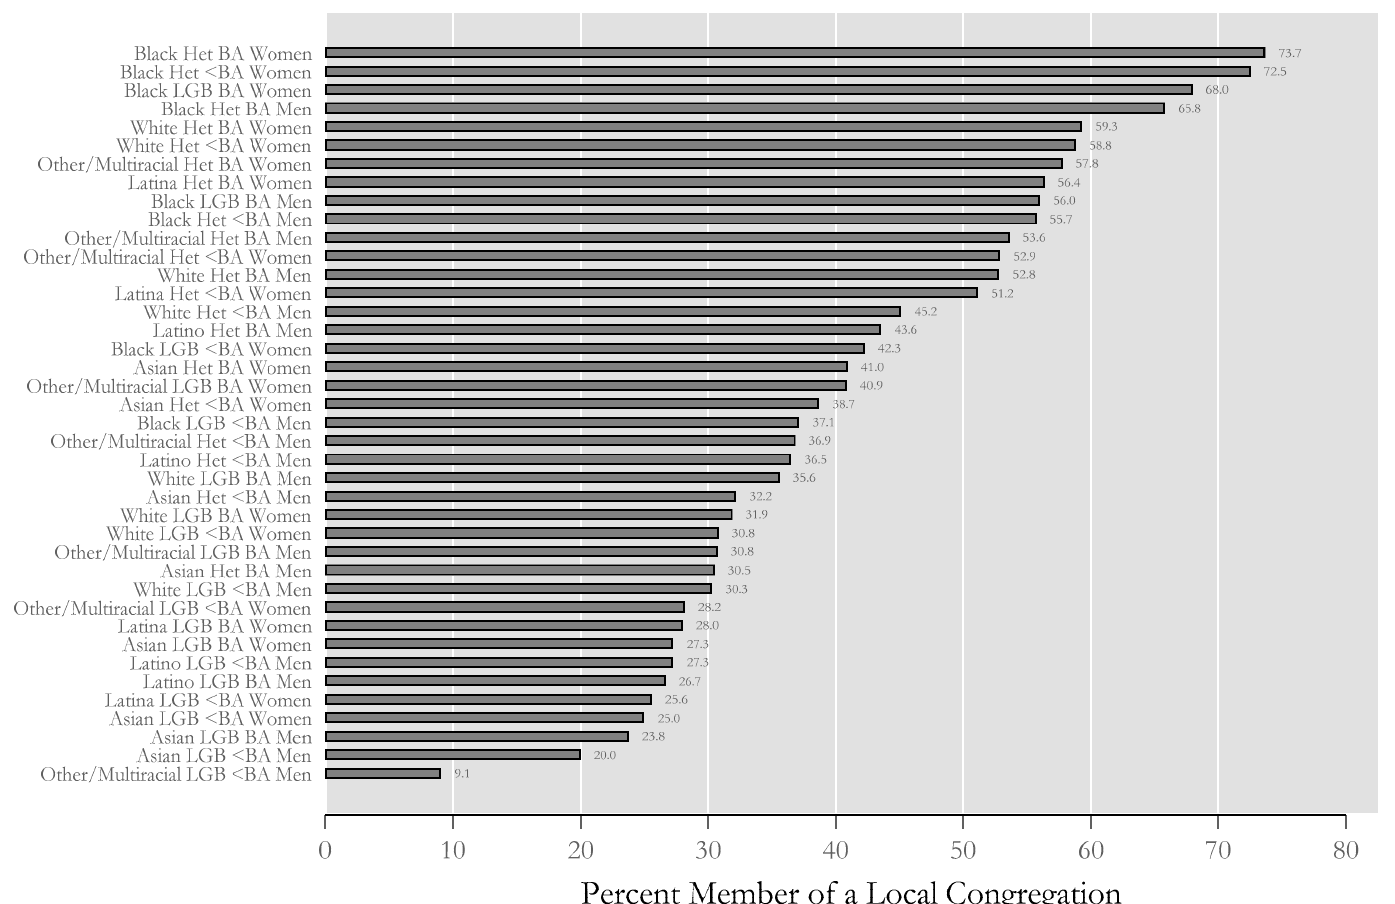
Figure 3. Membership in local congregations across configurations of status characteristics, RLS (N = 33,397).